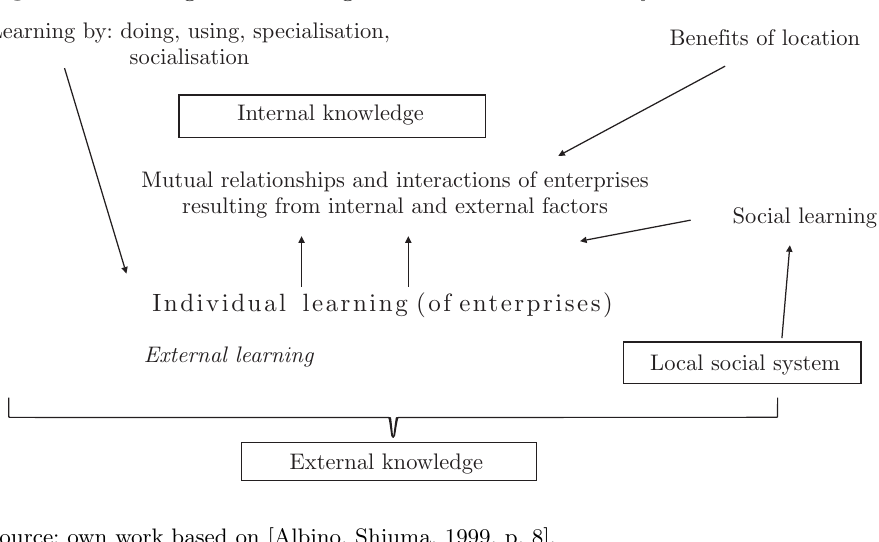
Figure 1. Learning and knowledge flows in local economic systems Learning by: doing, using,